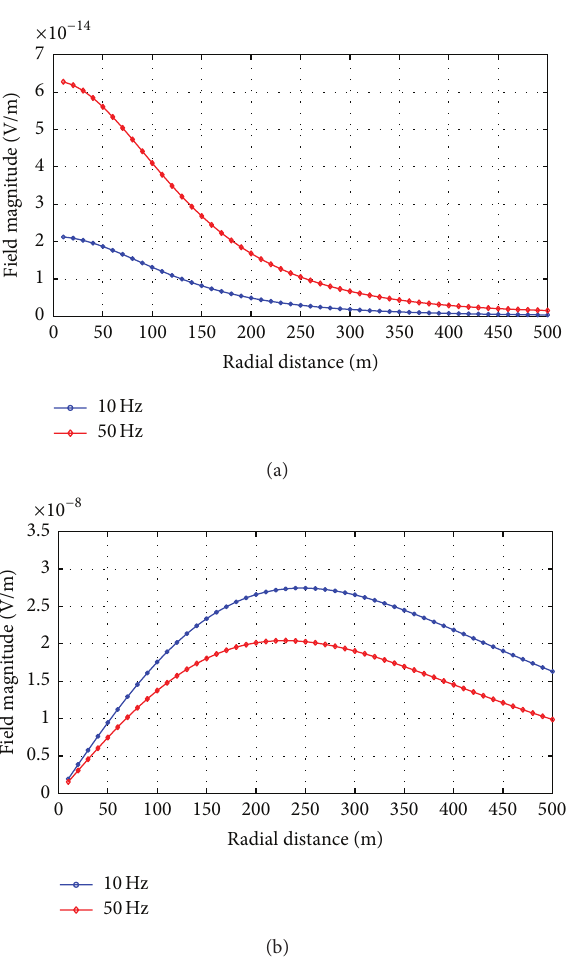
Figure 3: (a) Curves of the axial component of the electric field magnitude; (b) curves of the radial component of the electric field magnitude.